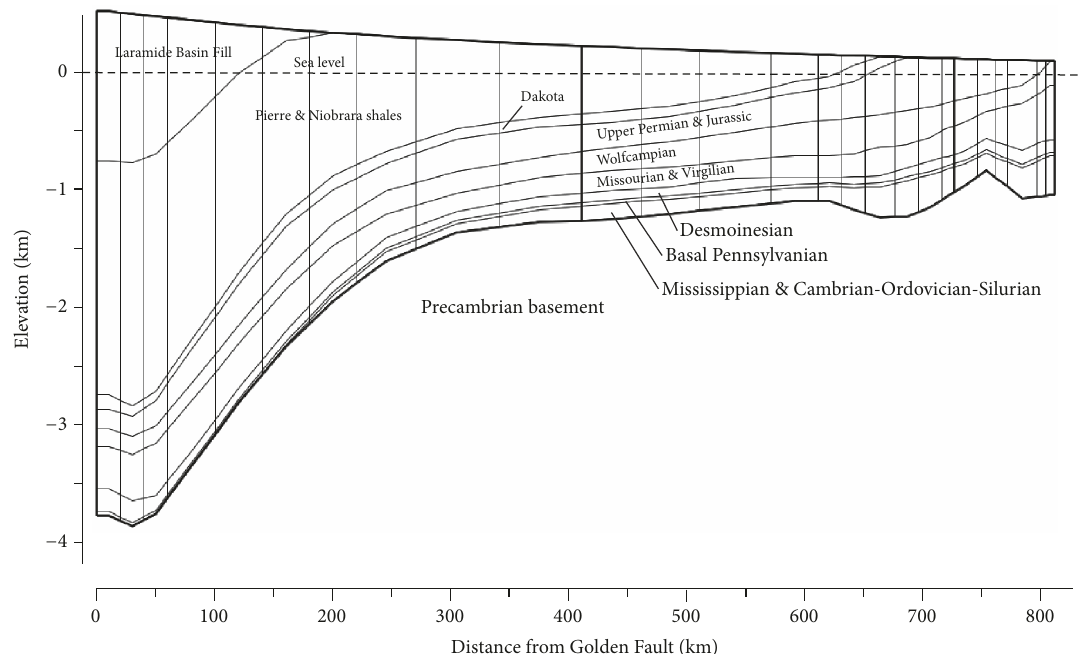
Figure 15: Grid of the second model of the sequence, having the geometry at 18Ma, used to model the period from 27 to 18Ma.